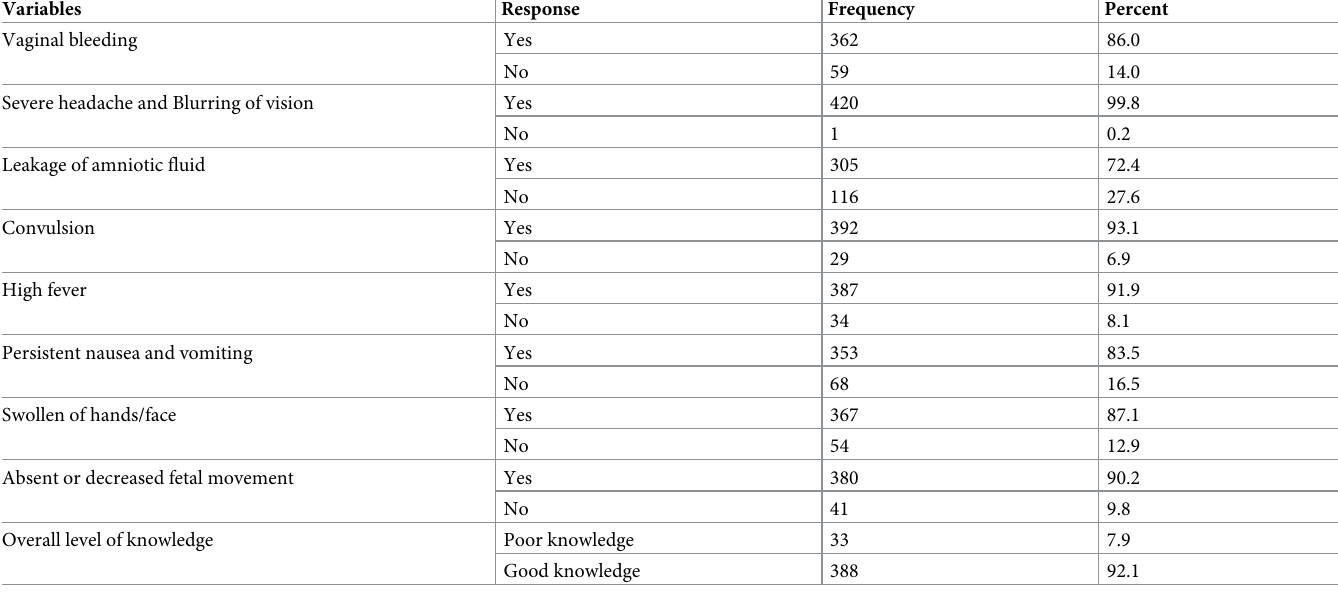
Table 3. Knowledge of obstetric danger signs during pregnancy among husbands in Kucha district, Gamo zone, Southern Ethiopia, 2018.